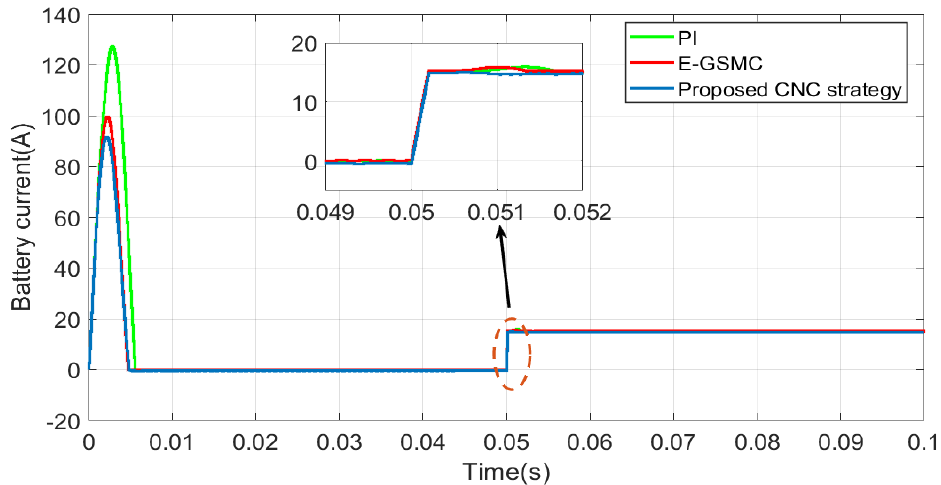
Figure 4. The dynamic response curve of the battery current.